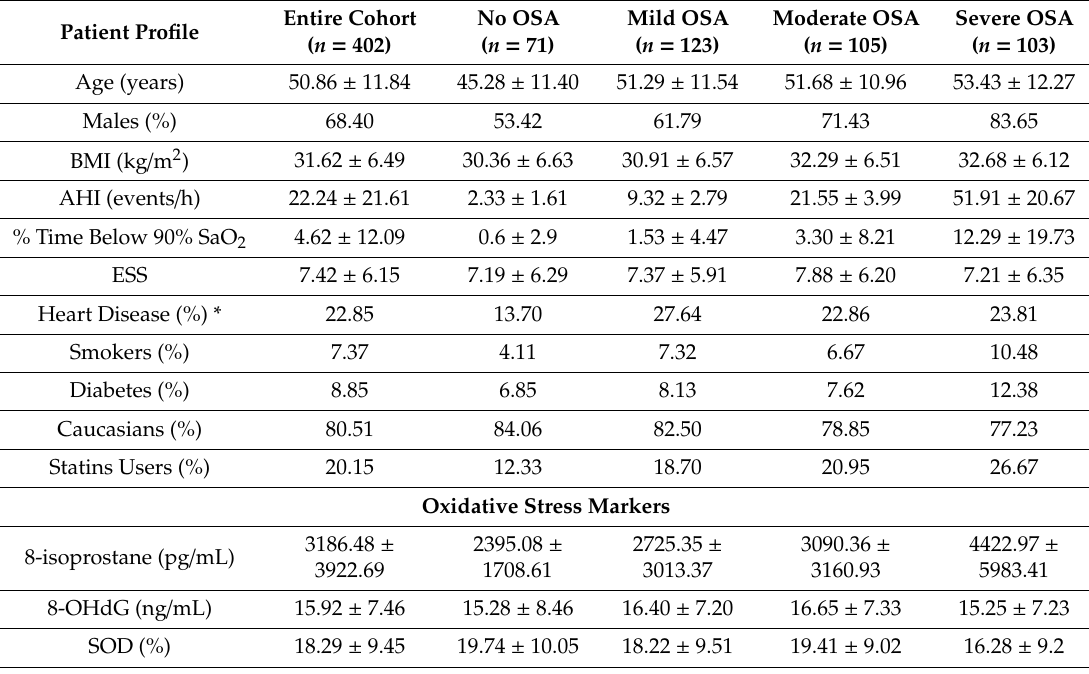
Table 1. Baseline